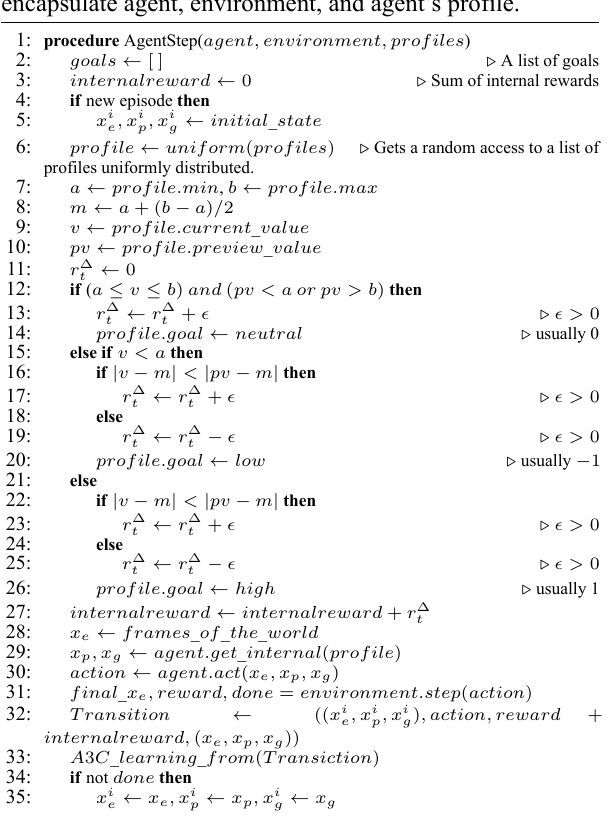
Algorithm 3 Agent-based on Explicit Randomic